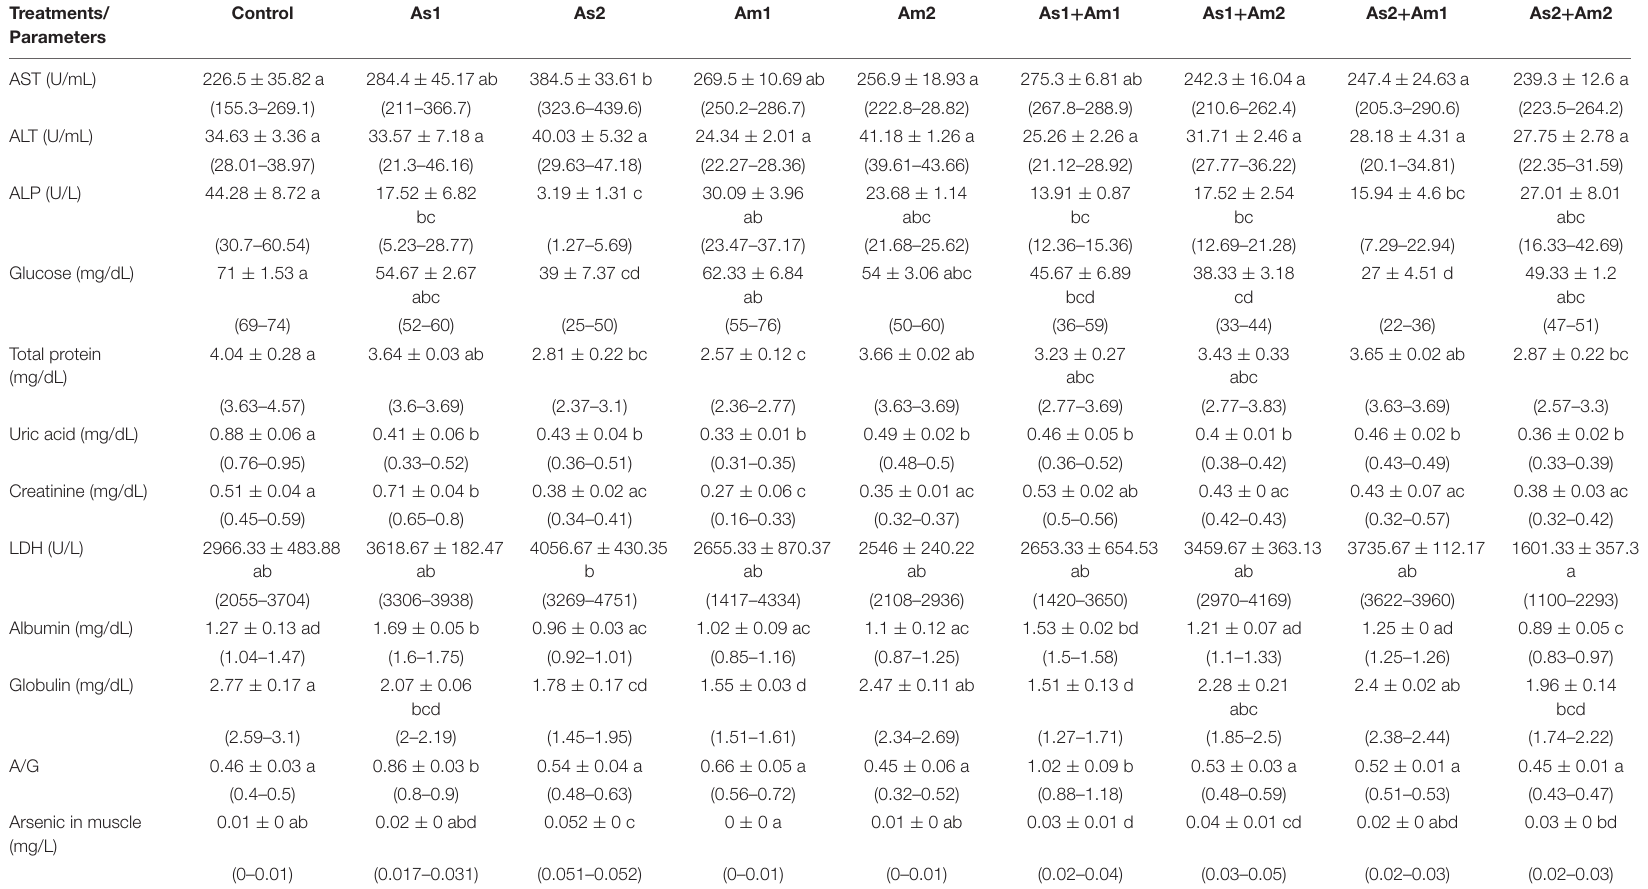
TABLE 4 | Values of blood constituent parameters and arsenic residue in the muscle of Clarias gariepinus exposed to arsenic, amphora and their combinations. Treatments/ Parameters